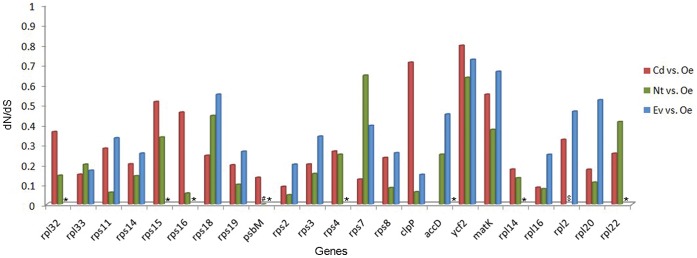
Pairwise dN/dS value of C. deserticola (Cd), E. virginiana (Ev) and N. tabacum (Nt) vs. O. europaea (Oe) for all shared protein-coding genes.*indicates gene lost, #indicates the absence of non synonymous substitutions, $indicates the absence of synonymous substitutions.